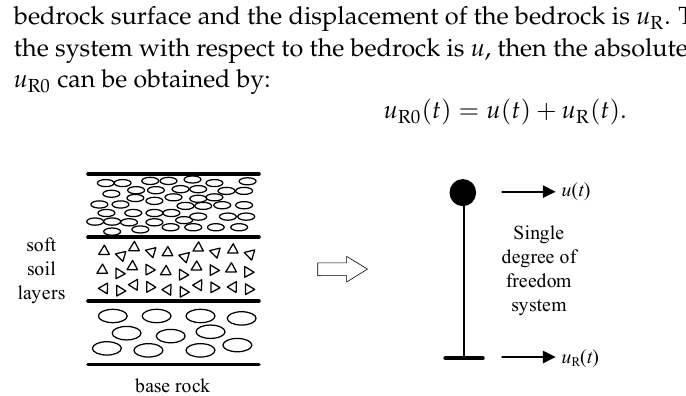
Figure 3. Equivalent single-degree-of-freedom of the local site.